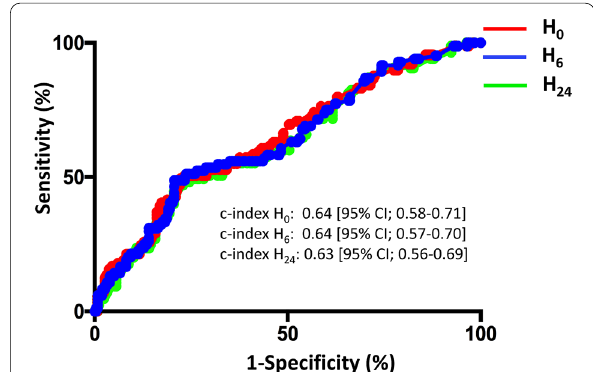
Fig. 2 Receiver operating characteristic (ROC) curves at any time (i.e., H 0 , H 6 and H 24 after inclusion) for the prediction of documented bacterial infection (including bacterial and viral coinfection) (BAC group) vs nondocumented bacterial infection + (i.e., documented viral infection alone or absence of documented pathogen) (BAC group) for the PCT −